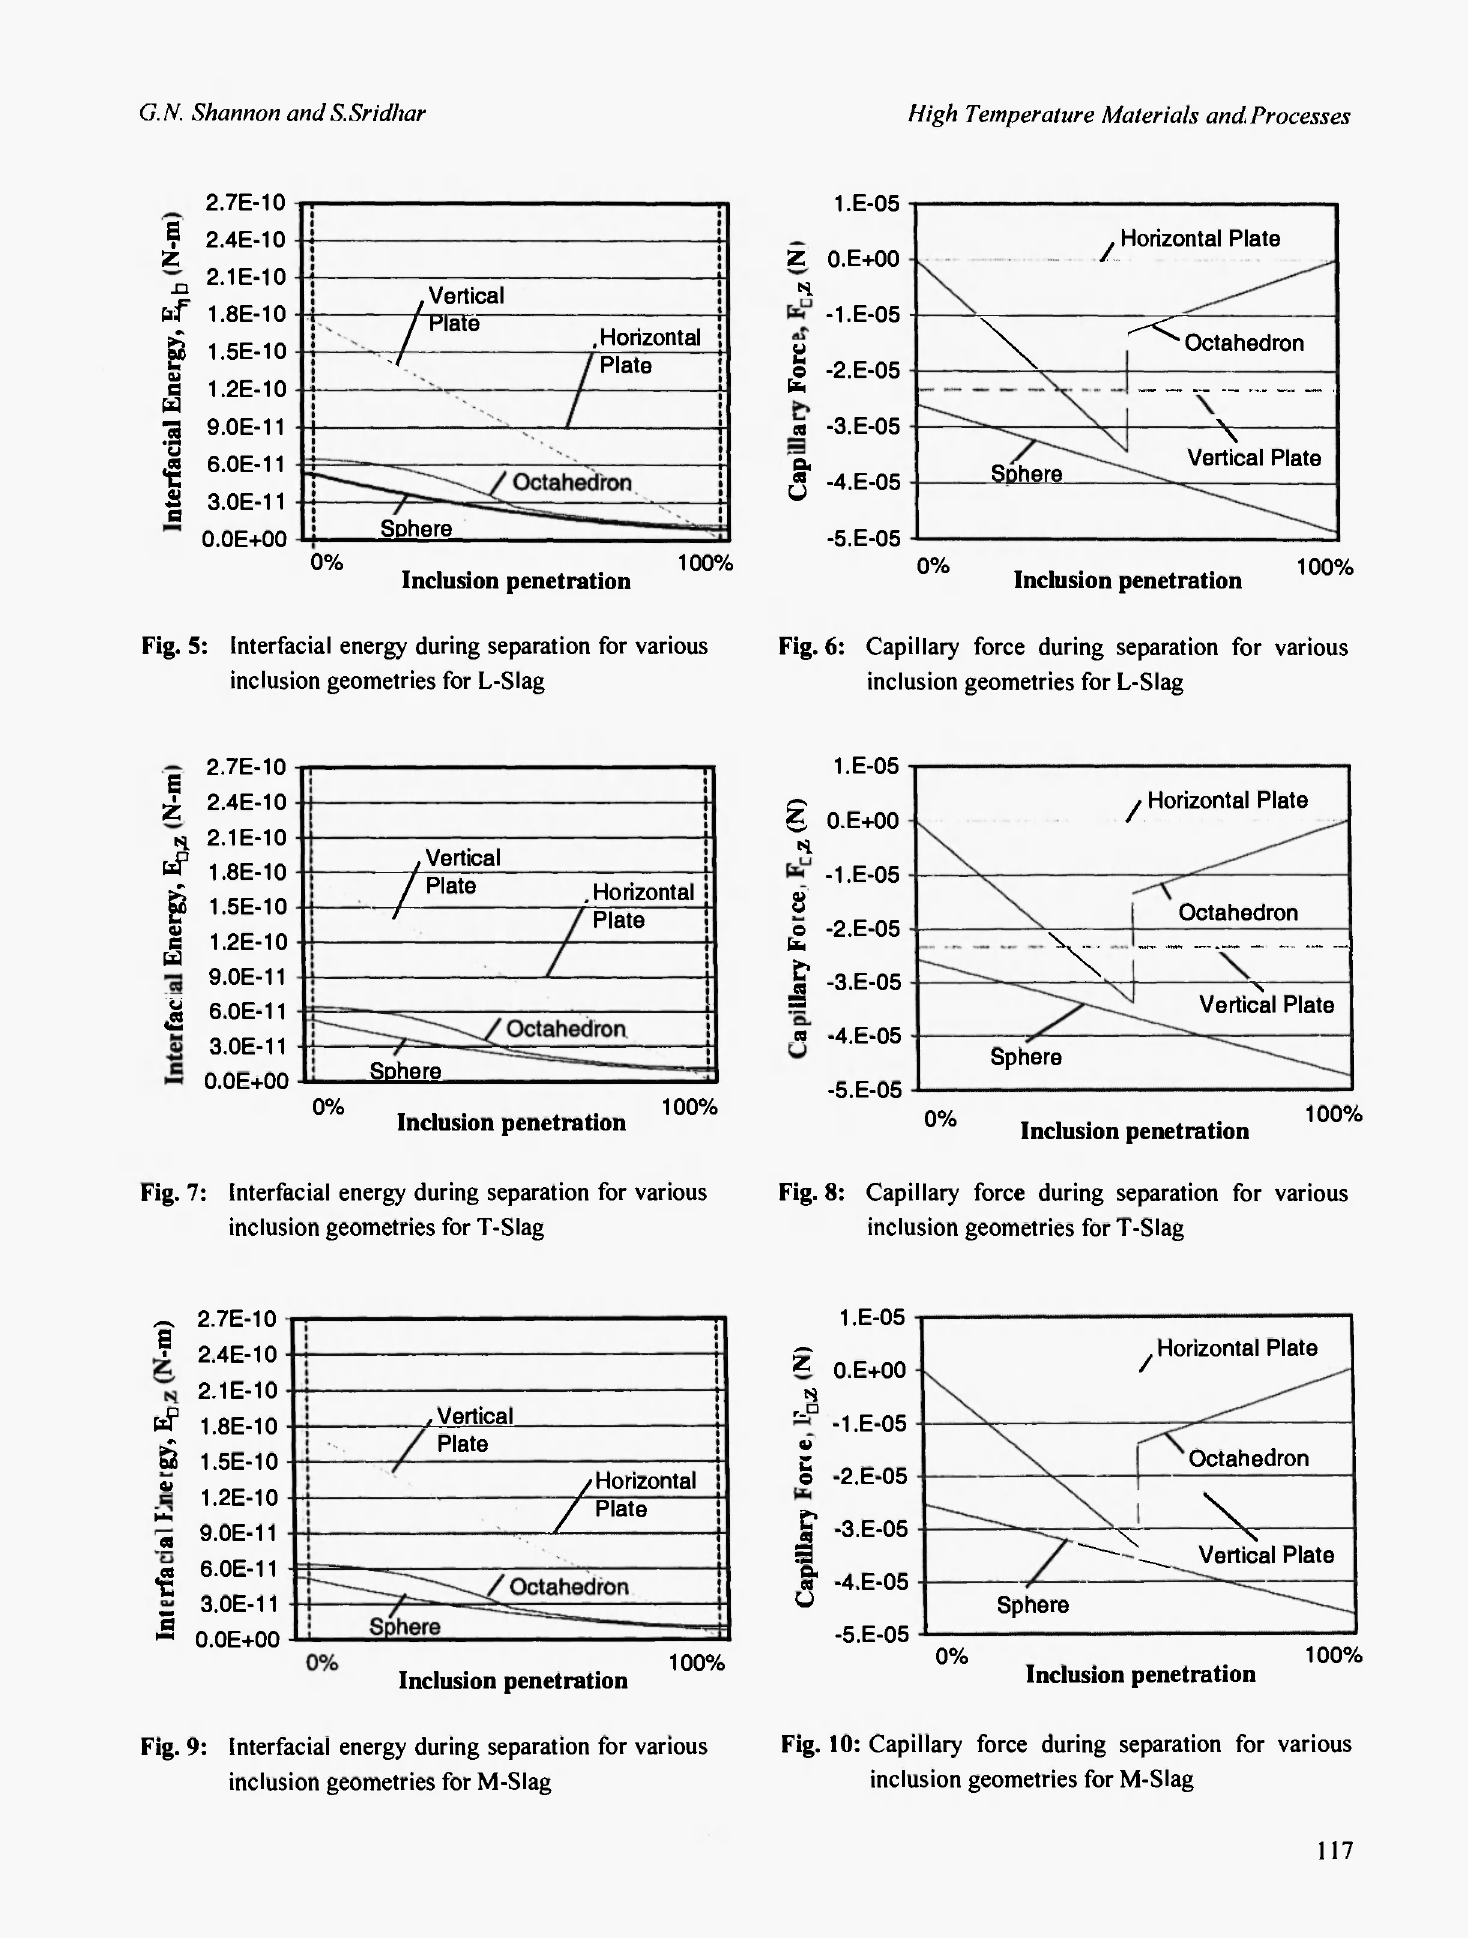
Fig. 9: Interfacial energy during separation for various inclusion geometries for M-Slag